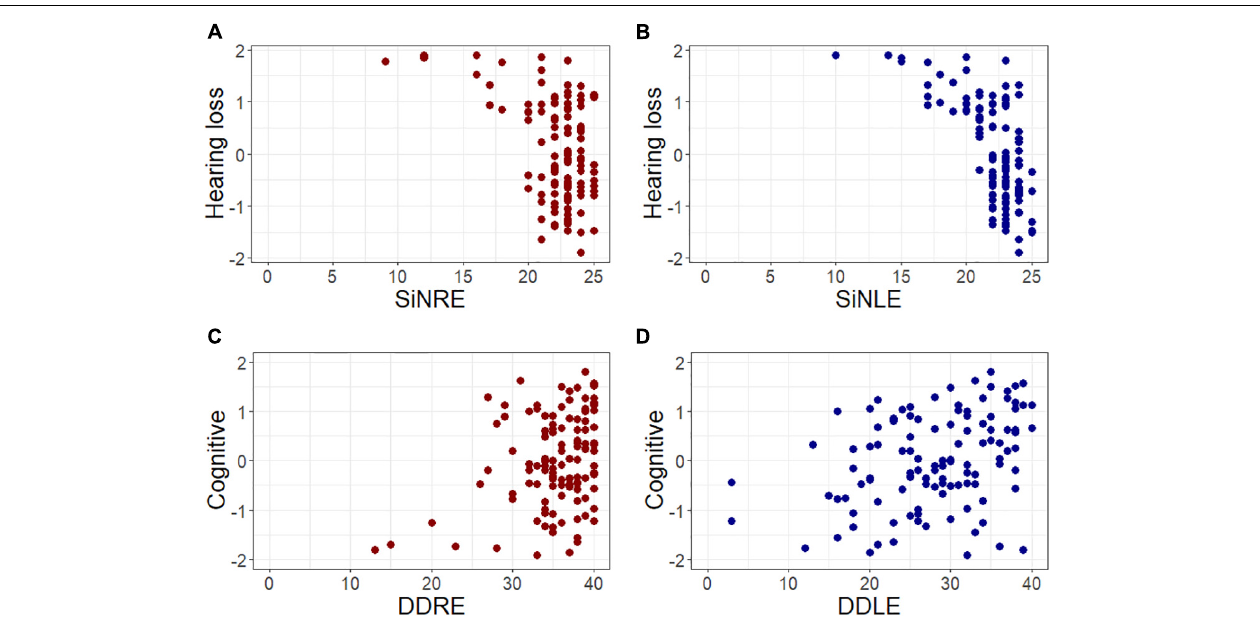
FIGURE 2 | Speech perception and dichotic listening are associated with hearing thresholds and cognition, respectively. Scatter plots presenting relevant associations found using generalized linear models. The panels present the association between (A) hearing loss and speech in noise for the right ear (SINRE), (B) hearing loss and speech in noise for the left ear (SINLE), (C) cognitive score and dichotic digits of the right ear (DDRE), and (D) cognitive score and dichotic digits of the left ear (DDLE). All variables are presented in z -score, red circles represent right ear evaluations, while blue circles illustrate left ear assessments.